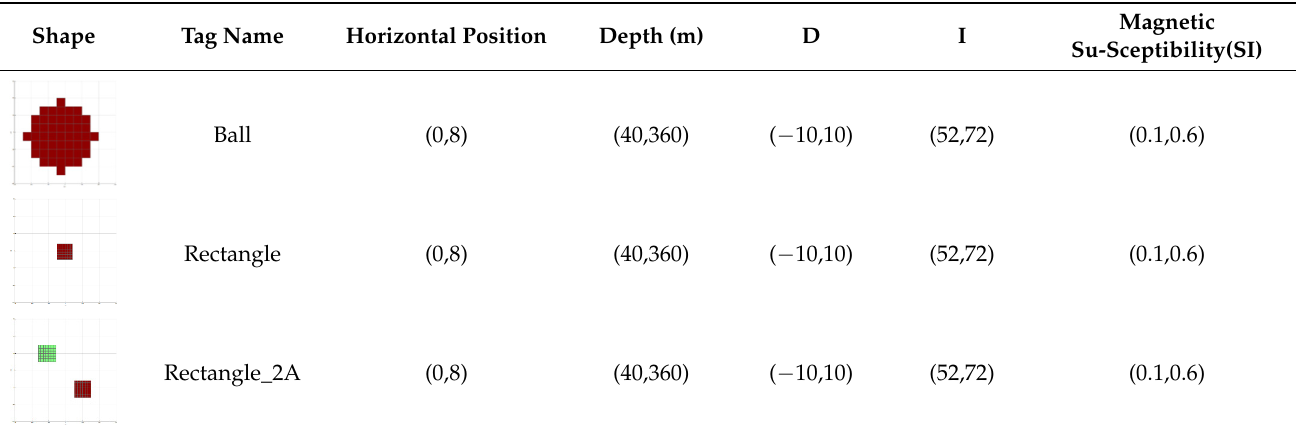
Table 1. Model types and parameter variation ranges.